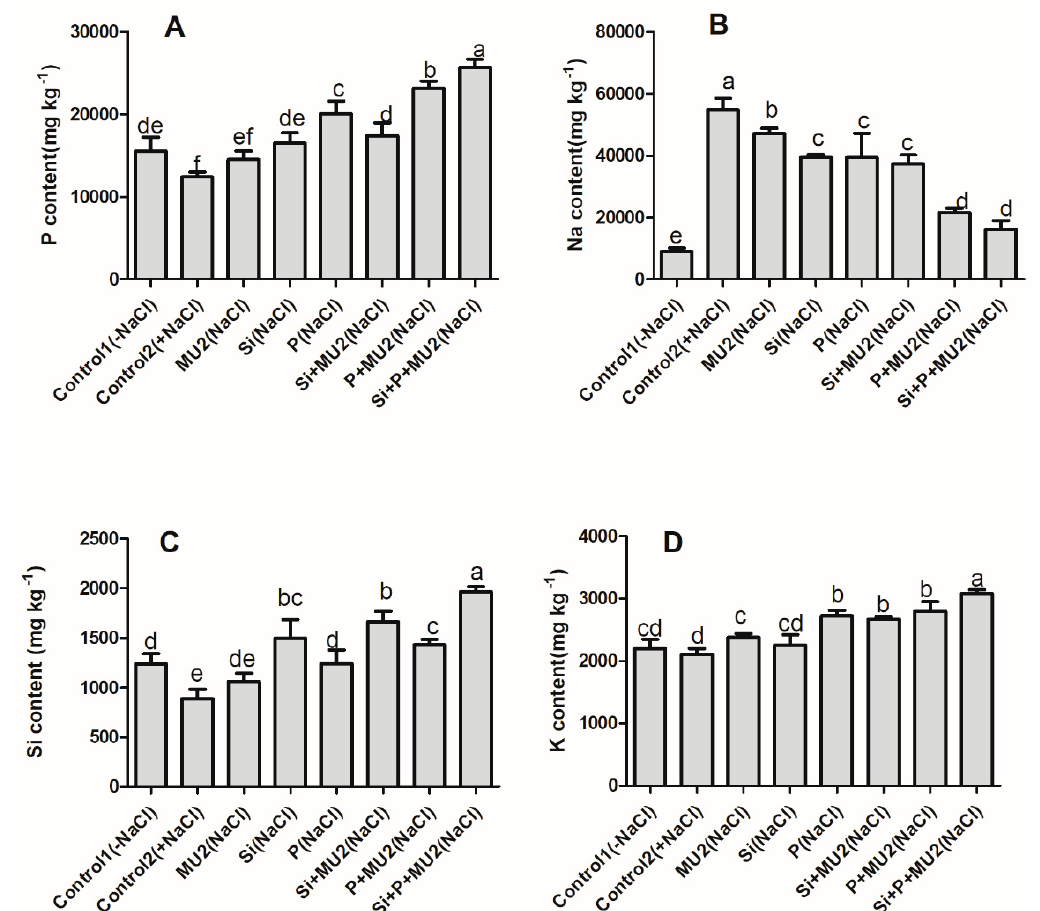
Figure 3. Concentration of different elements in soybean plants following the inoculation of P. koreensis MU2 under salt-stress conditions: ( A ) Phosphorus (P); ( B ) Sodium (Na); ( C ) Silicon (Si); ( D ) Potassium (K). Each data point represents the mean of at least three replicates. Error bars represent standard deviations. Bars with different letters are significantly different from each other at p ≤ 0.05.